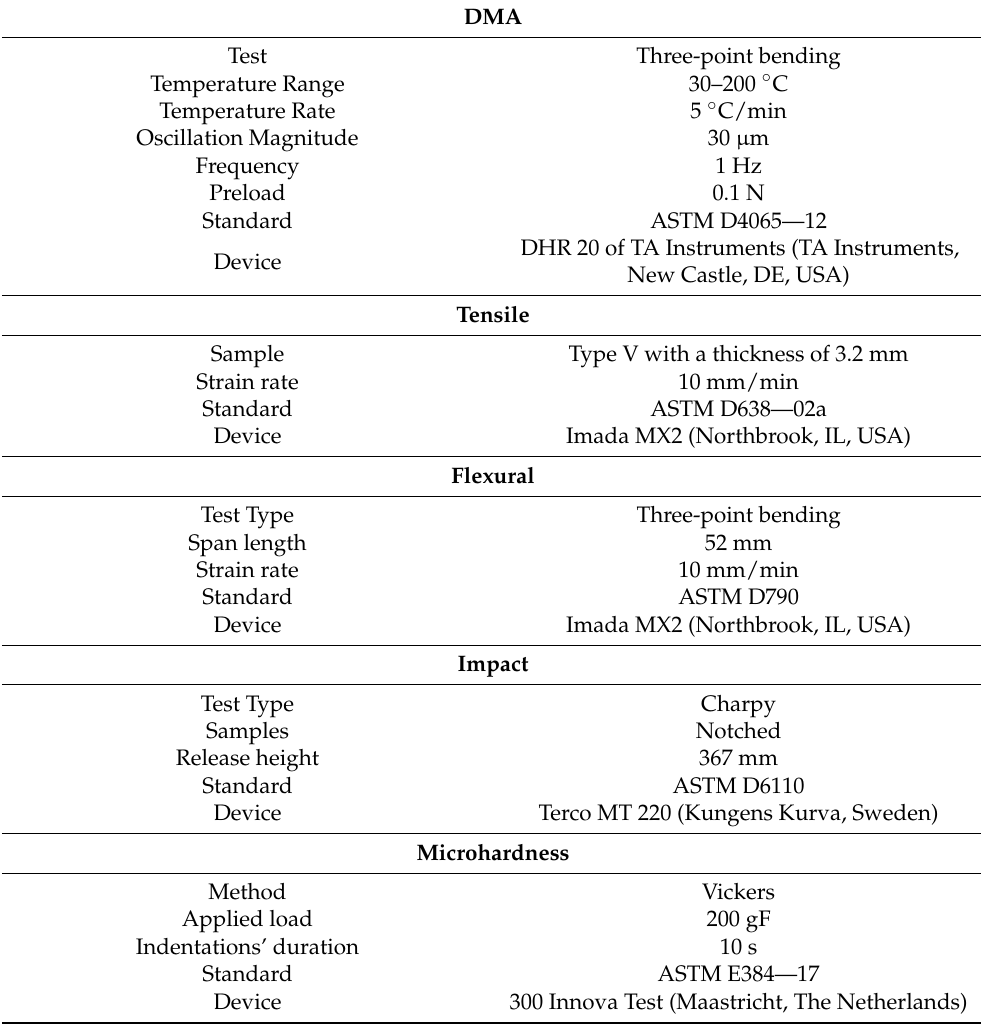
Table 1. Mechanical Characterization